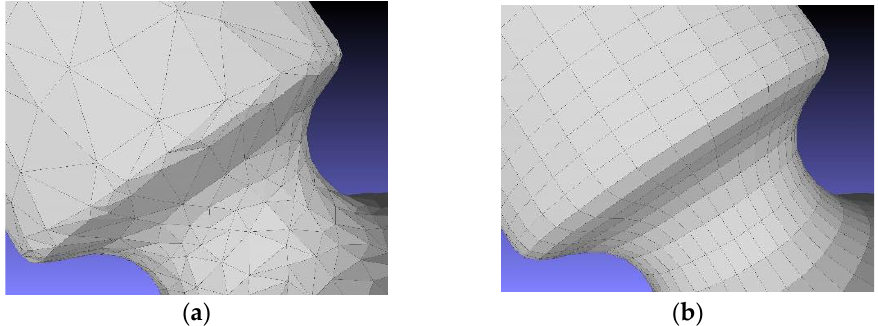
Figure 4. Difference between the triangular simplification ( a ) 9A and retopology simplification ( b ) on the lab specimen.